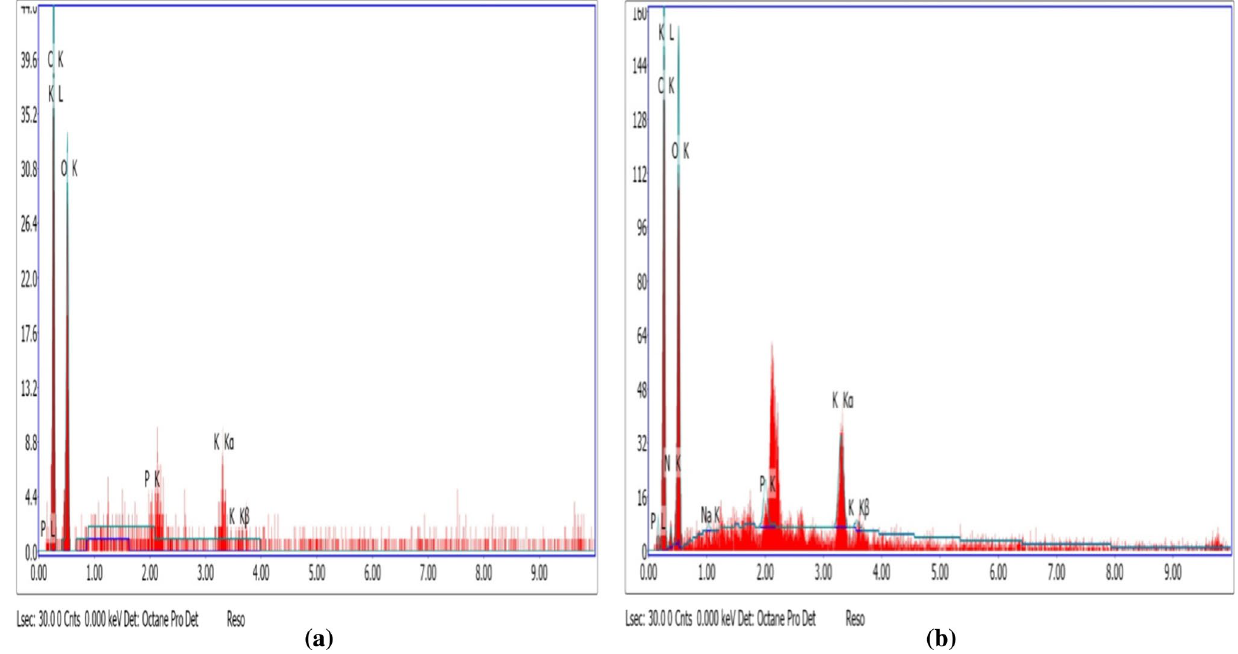
Fig. 5 a EDX analysis of Eichhornia crassipes leaves unloaded with phenol and cyanide and b loaded with phenol and